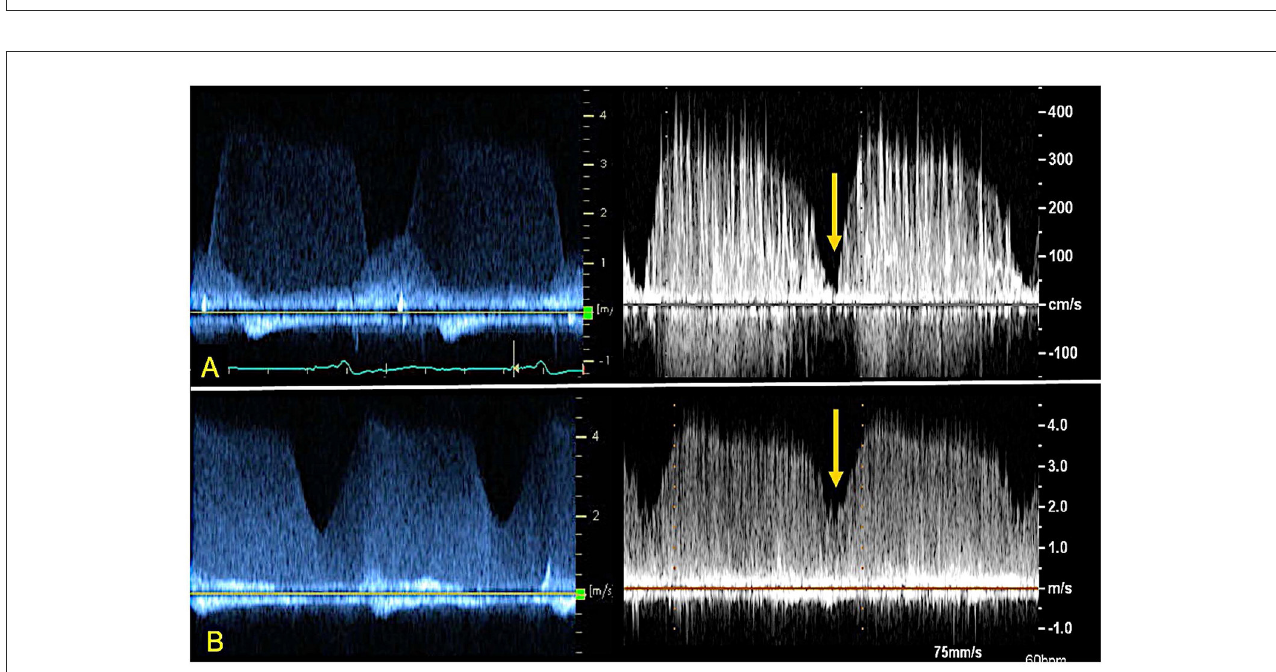
FIGURE5 CWD from index patient’s ramp study (left) and 3D printed model within the circulatory flow loop (right) depicting AR profile at different LVAD speeds. Note the loss of systolic dip in the CWD curve as the AR becomes “pancyclic” going from 8800 RPM (A) to 11000 RPM (B) of LVAD support. The yellow arrow indicates the “systolic